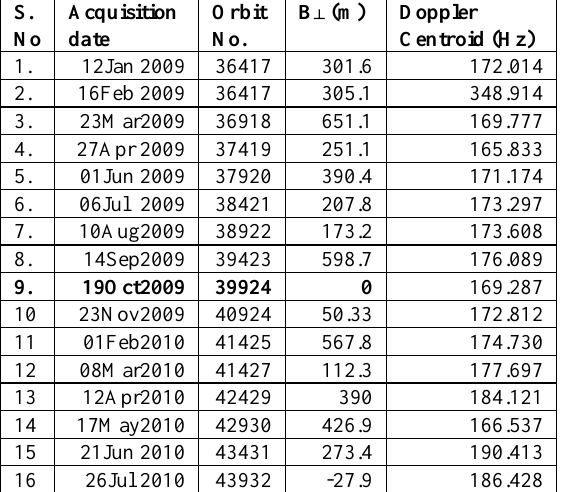
Table 1. ENVISAT data set of Tehri